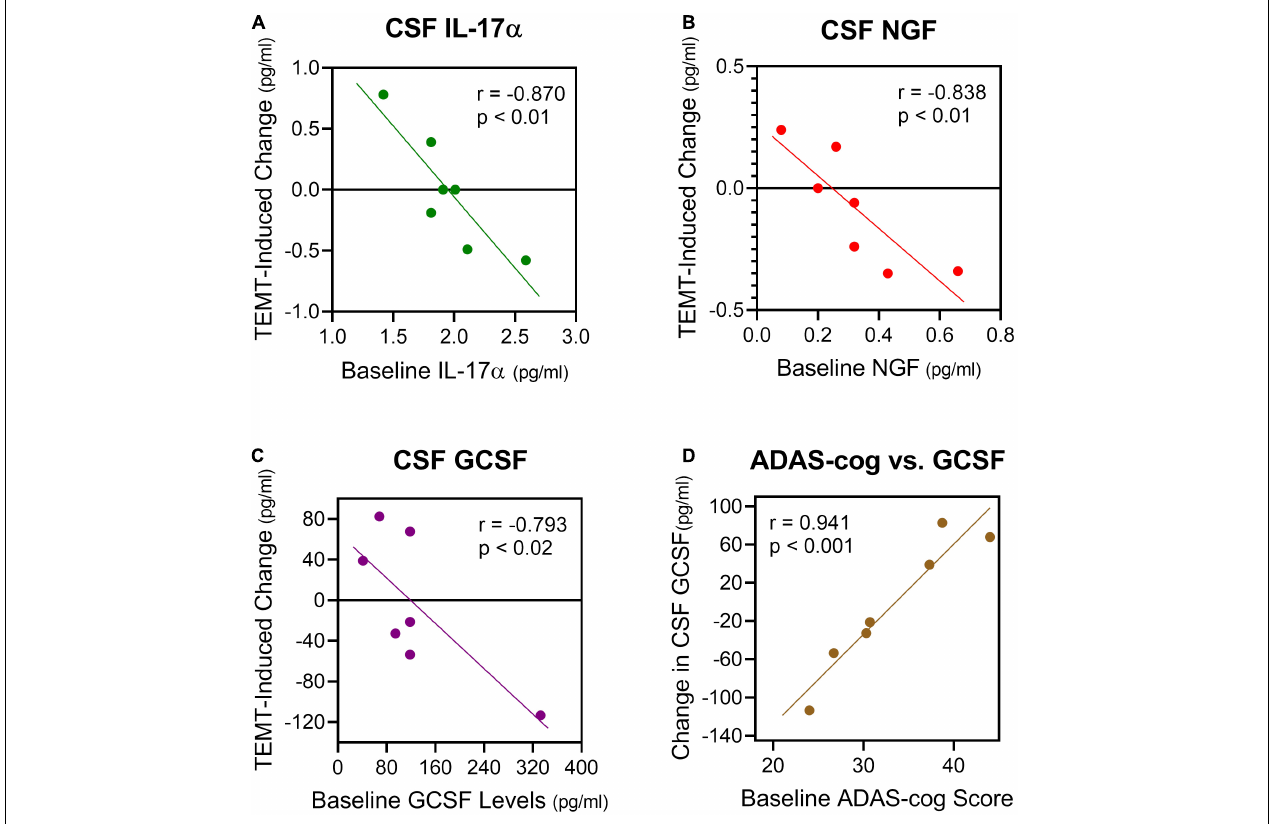
FIGURE 7 | (A–C) For five cytokines in CSF, 2 months of TEMT increased their CSF levels if lower levels were present at baseline, and just the opposite for higher CSF levels at baseline. Three examples of the significant correlations resulting from this rebalancing of CSF cytokine levels by TEMT are presented. Thus, baseline CSF levels of at least five cytokines determine the direction and extent of cytokine response to TEMT. (D) Baseline ADAS-cog scores correlated strongly with the response of GCSF in CSF to